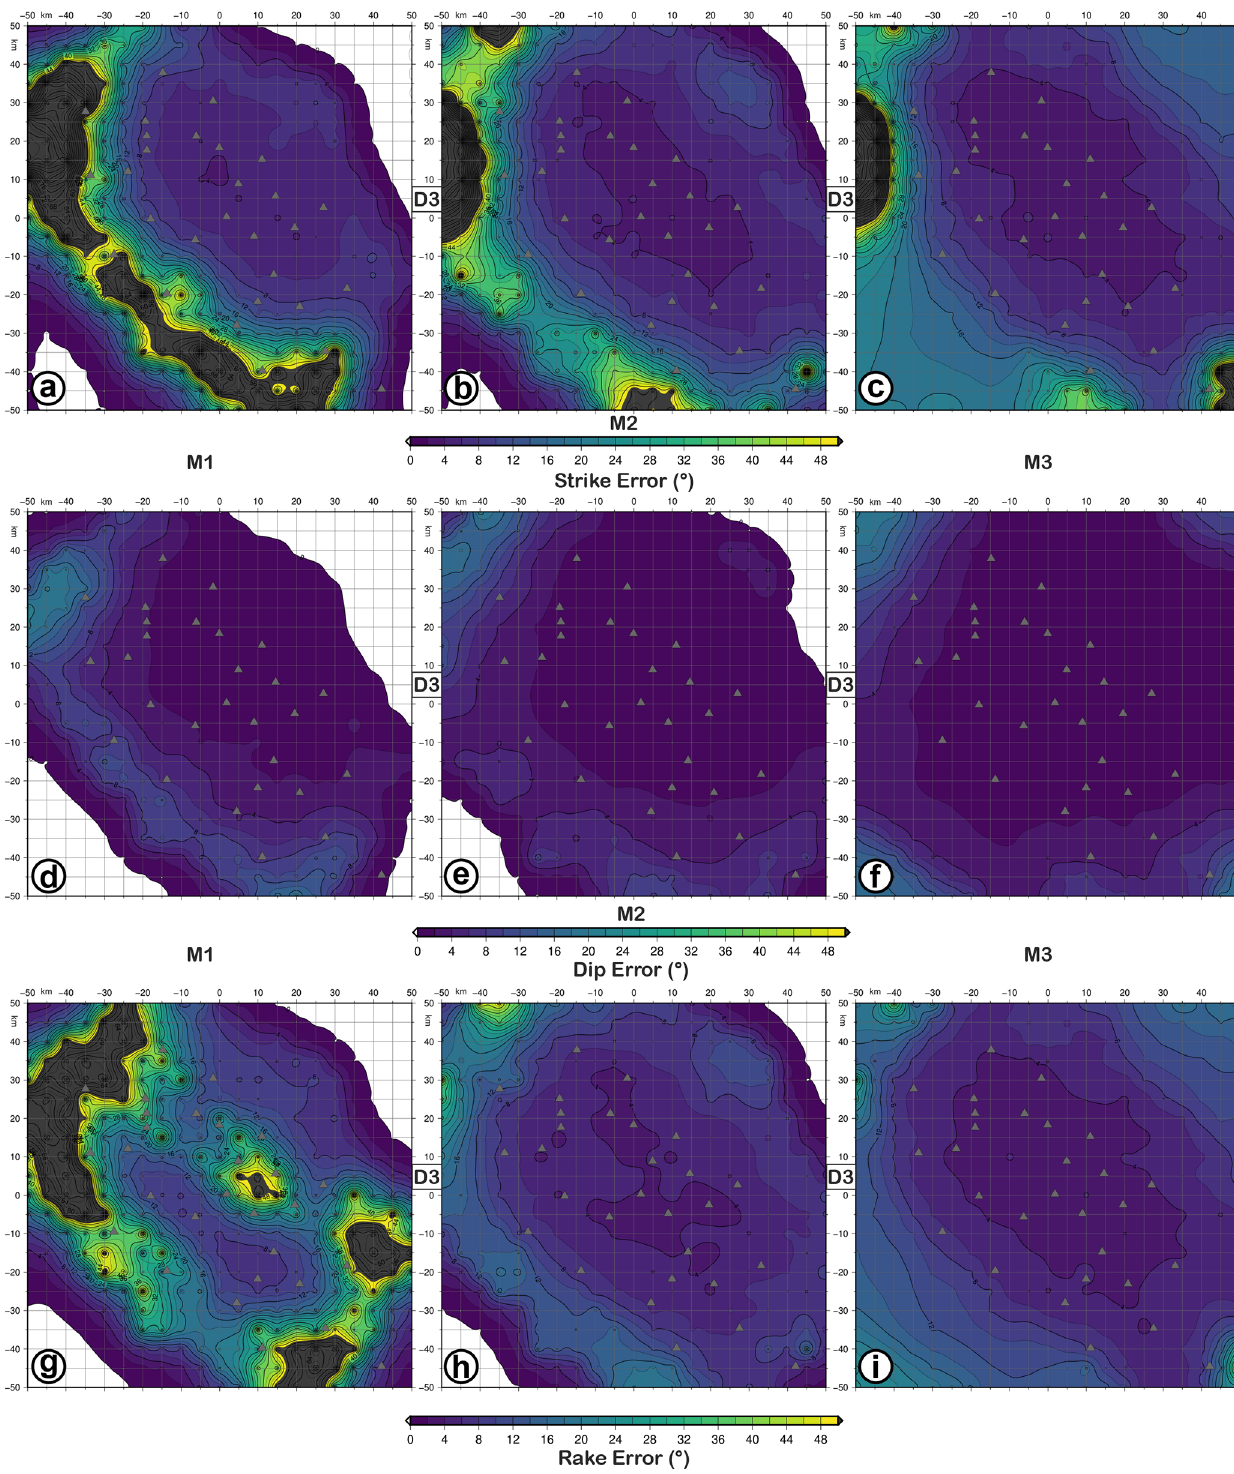
Figure 9. FME (strike, dip, and rake error) maps for retrieved focal mechanisms with D3 datasets as input data and simulating earthquakes with M1 (a, d, g) , M2 (b, e, h) , and M3 (c, f, i) magnitudes and the FM1 theoretical fault plane solution at 10km depth. Panels (a–c) refer to strike error; (d–f) refer to dip error; (g–i) refer to rake error. The level of Gaussian noise is set to 5%.